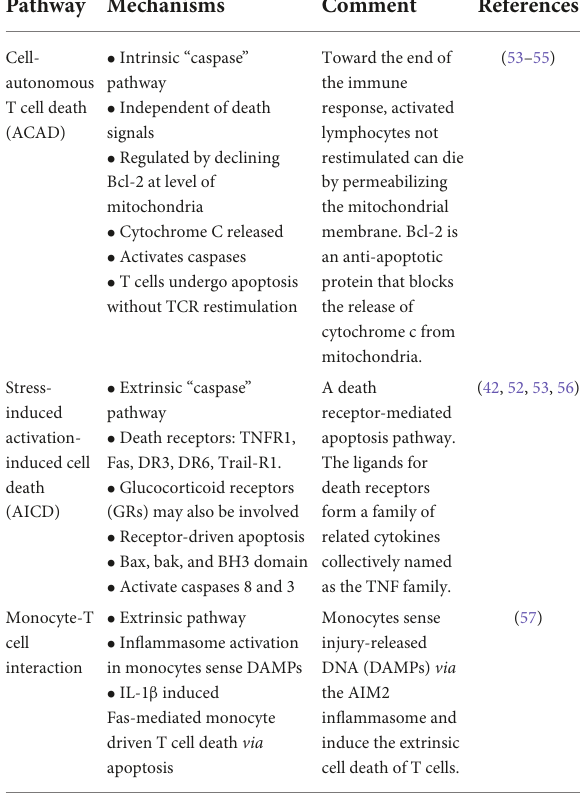
TABLE 1 Possible mechanisms for T-cell apoptosis and immunosuppression after major